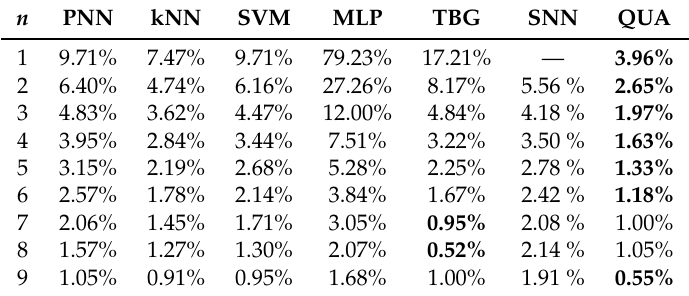
Table 3. Gesture recognition error rate. The first column, labelled n , denotes the number of training samples per class. The best result in a given row is shown in bold and indicates the least erroneous classifier.